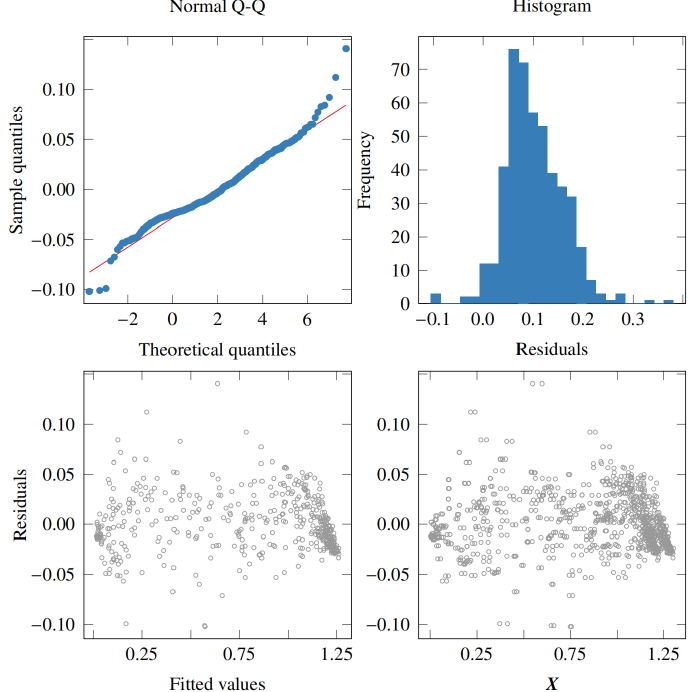
Figure 7. The residual diagnosis of the statistical interpolation in sub-region No.